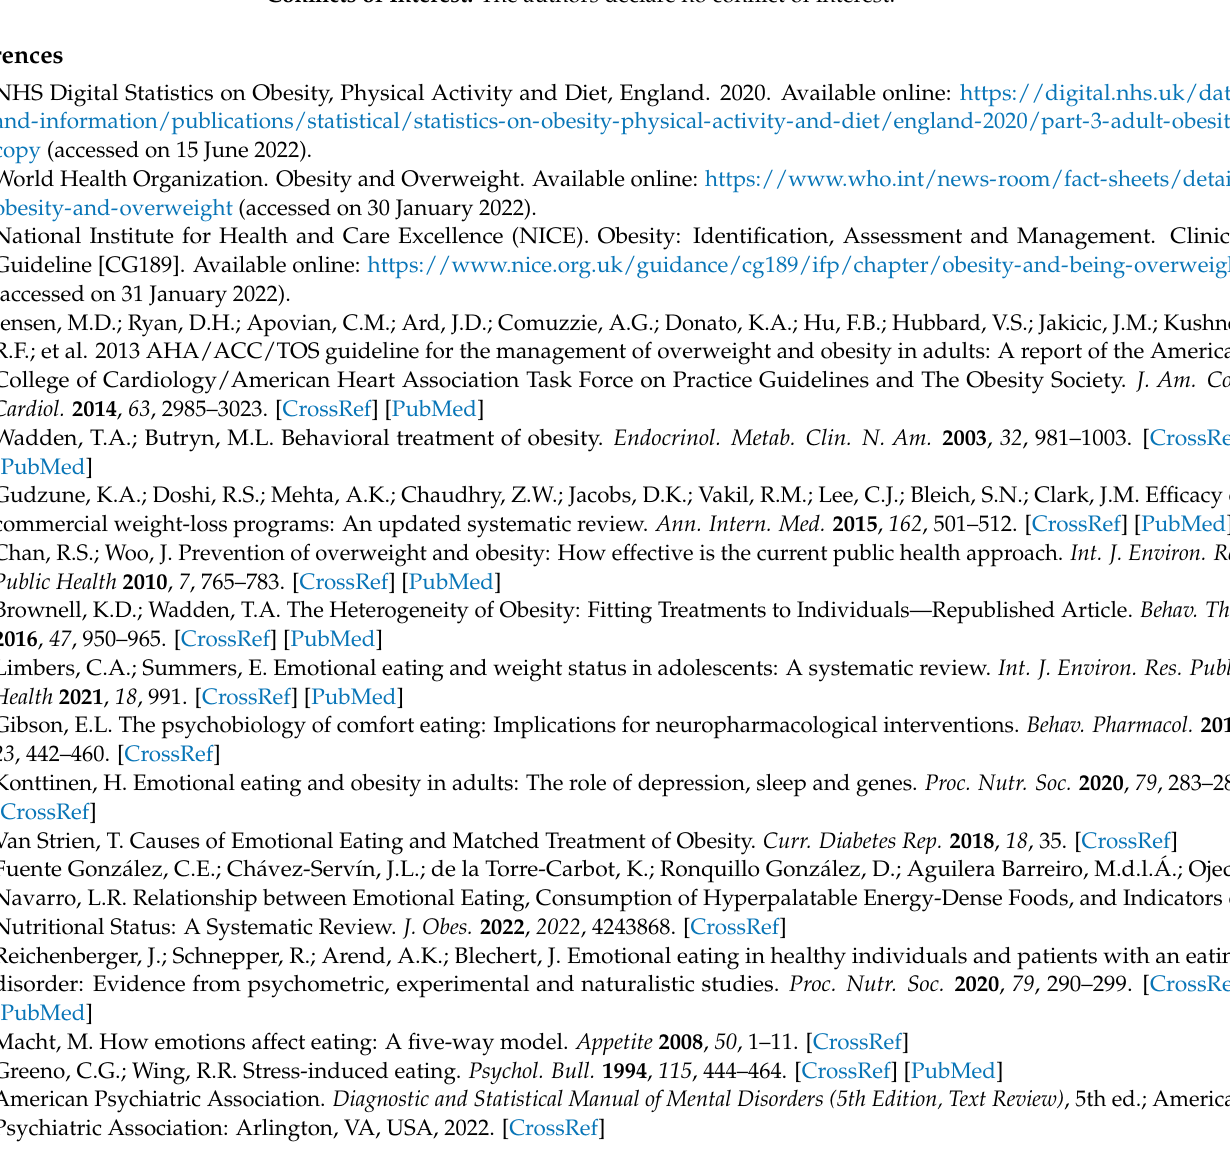
Table S2: Results of Included Studies; Table S3: Hierarchy of Inclusion and Exclusion Criteria; Table S4: Critical Appraisal Tool For Randomised Control Trials [61]; Table S5: JBI Checklist for Quasi-Experimental Studies (Non-Randomised Experimental Studies)